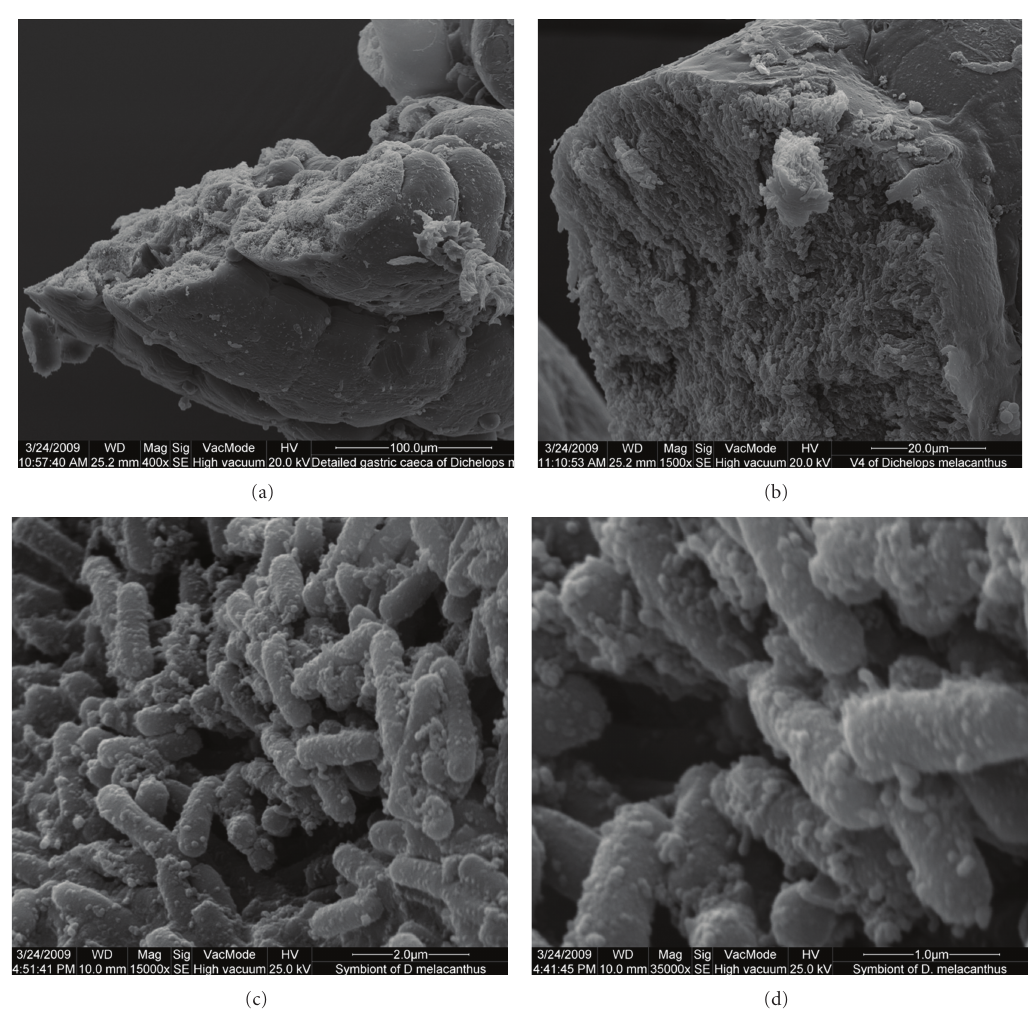
Figure 3: Detailed figure of scan electron microscopy (SEM) of the gastric caeca of Dichelops melacanthus in (a), detail of the amount of bacteria inside the gastric caeca in (b), and bacteria detail in (c) and (d). The impact of surface sterilization on the maintenance of the symbionts and on the development of E. heros ,